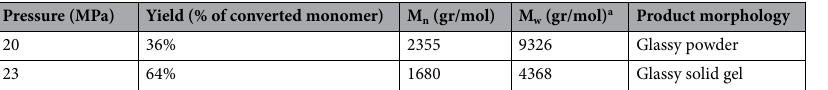
Table 4. The effect of SC-CO 2 pressure on the linear precursor synthesis T = 70 °C W i /W m = 1.5%, W t / W i = 83.3%, and time = 6 h. a Molecular weight measured with GPC.